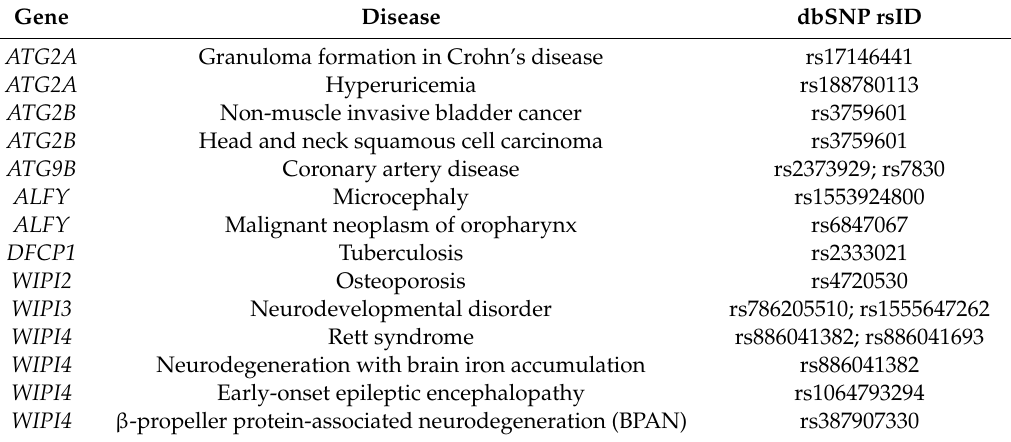
Table 3. Clinically relevant SNPs in PI(3)P-binding proteins and ATG9 orthologues.